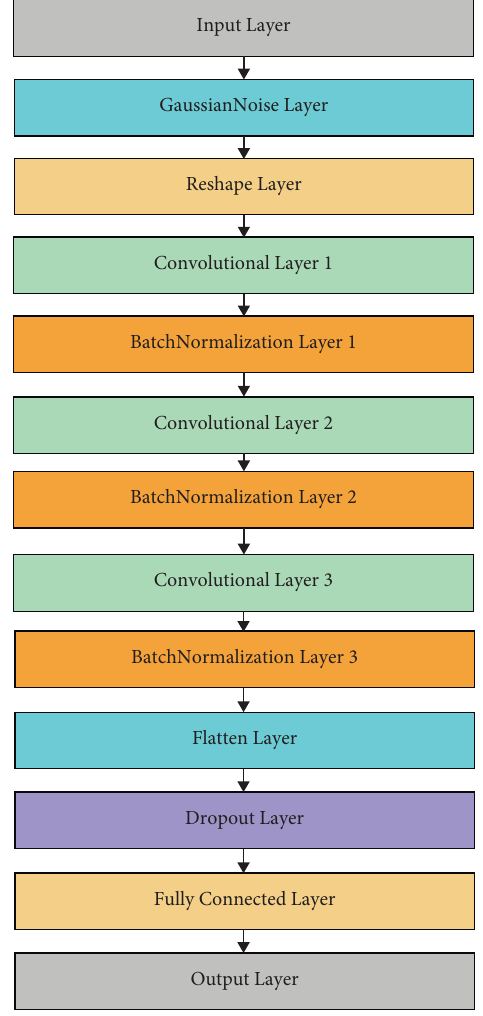
Figure 5: 1DCNN model